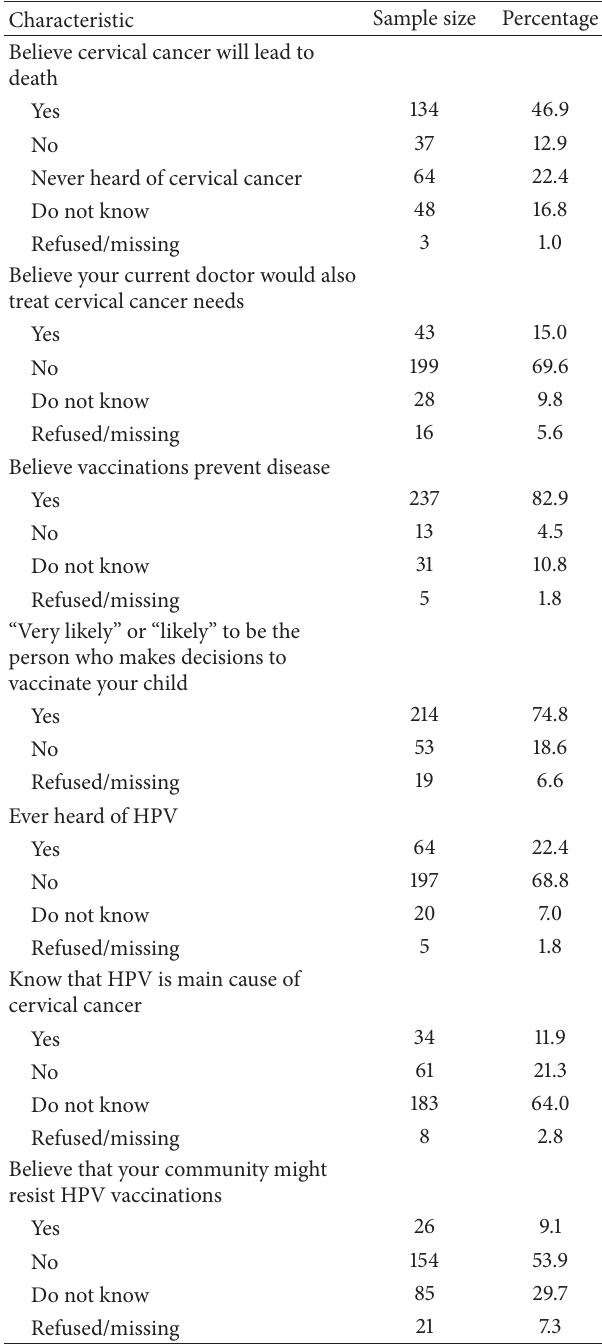
Table 2: Knowledge, attitudes, and self-efficacy outcomes, Odisha, India ( 𝑛 = 286